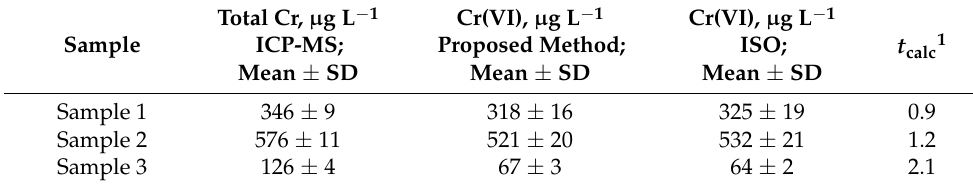
Table 2. Comparative analysis of ground waters from region of Yambol (5 parallel determinations). In all cases, t calc is below t crit = 2.73 (95%, 9).